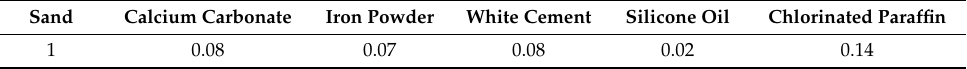
Figure 3. The similar material components and the specimen. ( a ) Basic composition of the material; ( b ) production of similar material specimen. ( b ) production of similar material specimen. Table 1. Similar material proportion. Table 1. Similar material proportion.